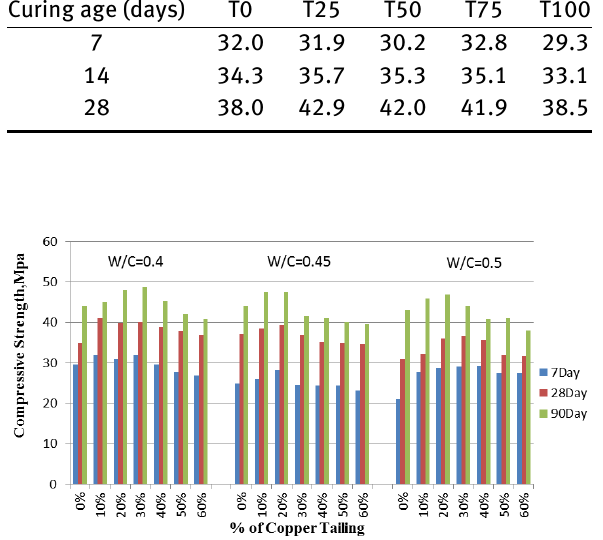
Figure 9: Compressive strength of concrete containing tailings